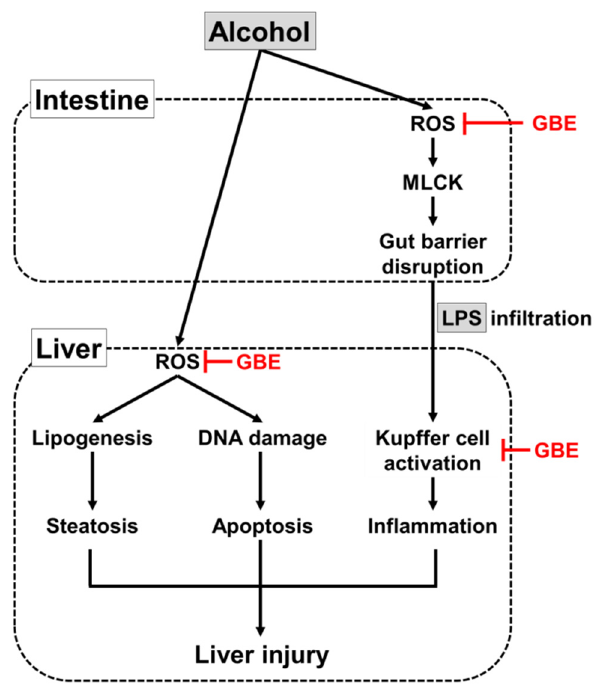
Figure 5. Proposed mechanism of protection of GBE against alcohol-induced liver injury. Alcohol-induced reactive oxygen species (ROS) and oxidative stress induce hepatic steatosis and apoptosis through lipogenic pathway and DNA damage response, respectively. In addition, ROS promote gut barrier disruption and subsequent LPS infiltration into the liver, resulting in inflammatory responses via Kup ff er cells activation during alcoholic liver injury. GBE may protect the liver from alcoholic damage by suppressing ROS-induced oxidative stress in both intestine and liver and Kup ff er cell activation. Black and red lines indicate stimulatory and inhibitory actions,